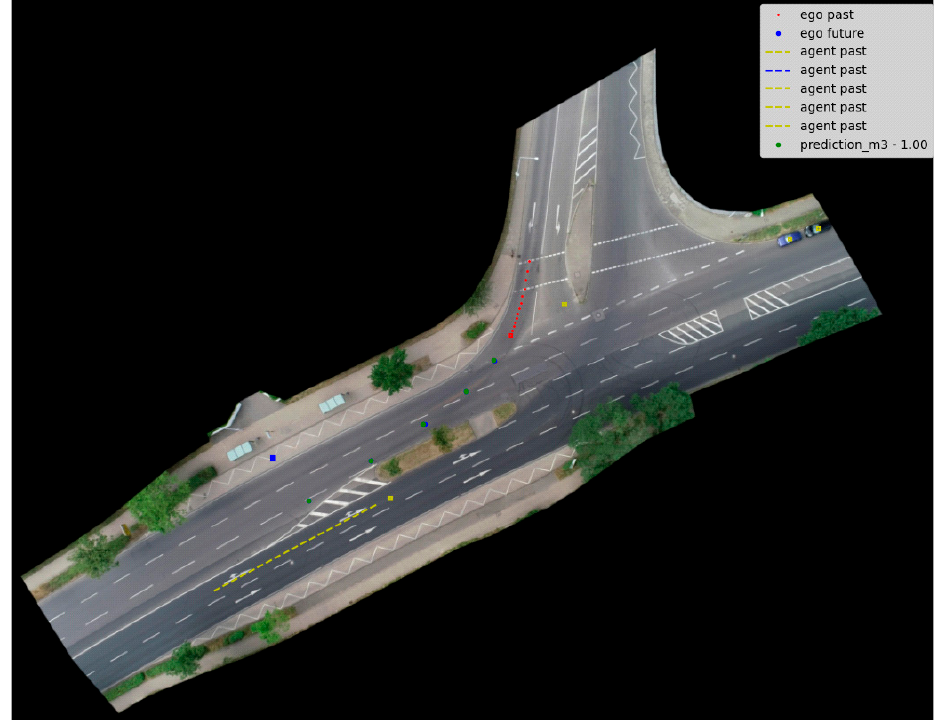
Figure 18. Tra ffi c scene prediction with the unimodal approach and a reduced number of predic- tion points. Table 5. Unimodal results with fewer predicted points.